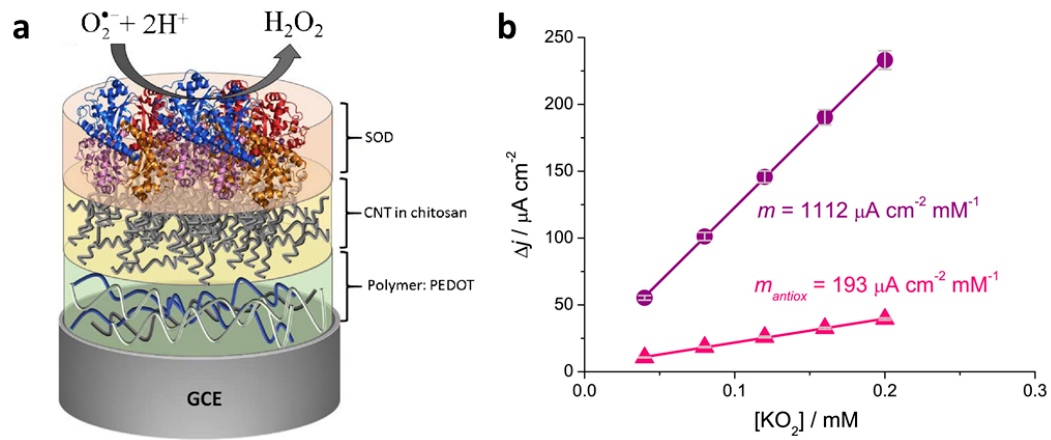
Figure 8. ( a ) Optimal electrode configuration, with PEDOT deposited on a glassy carbon electrode, coated with CNTs in chitosan, which are then coated with superoxide dismutase (SOD). ( b ) Example of determination of relative antioxidant capacity of wine; increasing amounts of KO 2 are added to the SOD/CNT/PEDOT/GCE sensor in the absence (circles) and presence (triangles) of red wine (8 µL added to 2 mL solution of 0.1 M sodium phosphate buffer containing 0.05 M NaCl (pH 7.0) at an applied potential of − 0.3 V vs. Ag/AgCl [43]. Reprinted from Sensors and Actuators B: Chemical , Vol.